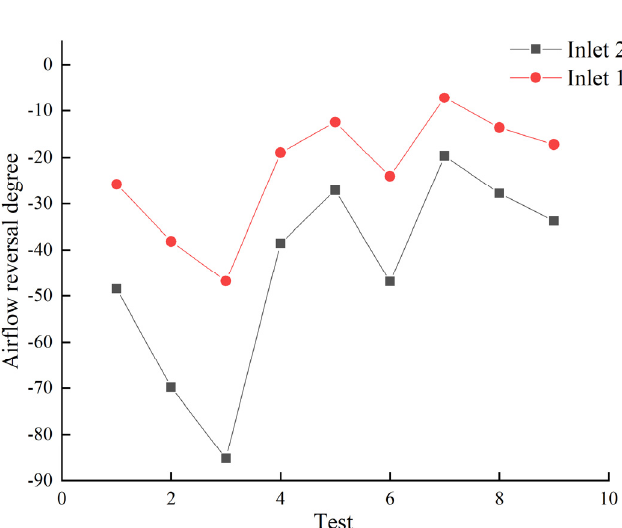
Figure 8. Variation of air velocity and airflow reversal degree.